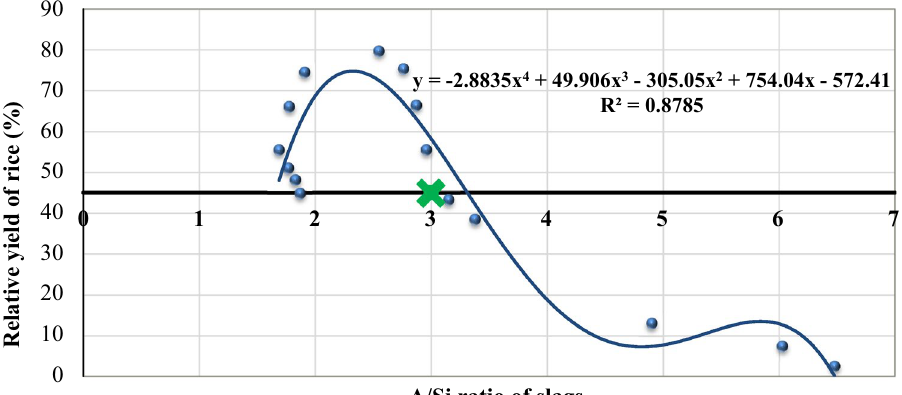
Figure 1. Relationship between A/Si of slags and relative yield of wet land rice [**significant at p < 0.01 (each data represents an average of three